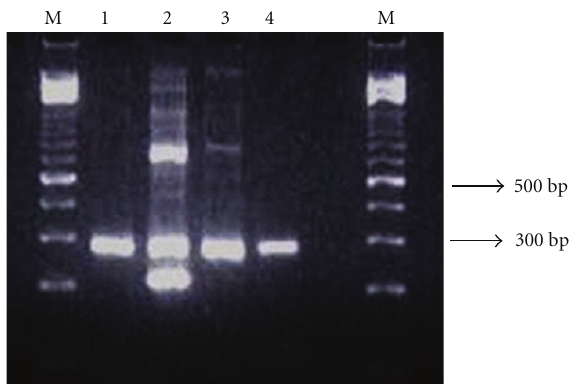
Figure 2: DNA analysis of sex chromosome of the heifer ( M is ladder marker of 100 bp). Lane 1: Heifer with athelia, Lane 2: Normal bull, Lane 3: Normal heifer, Lane 4: Normal cow.